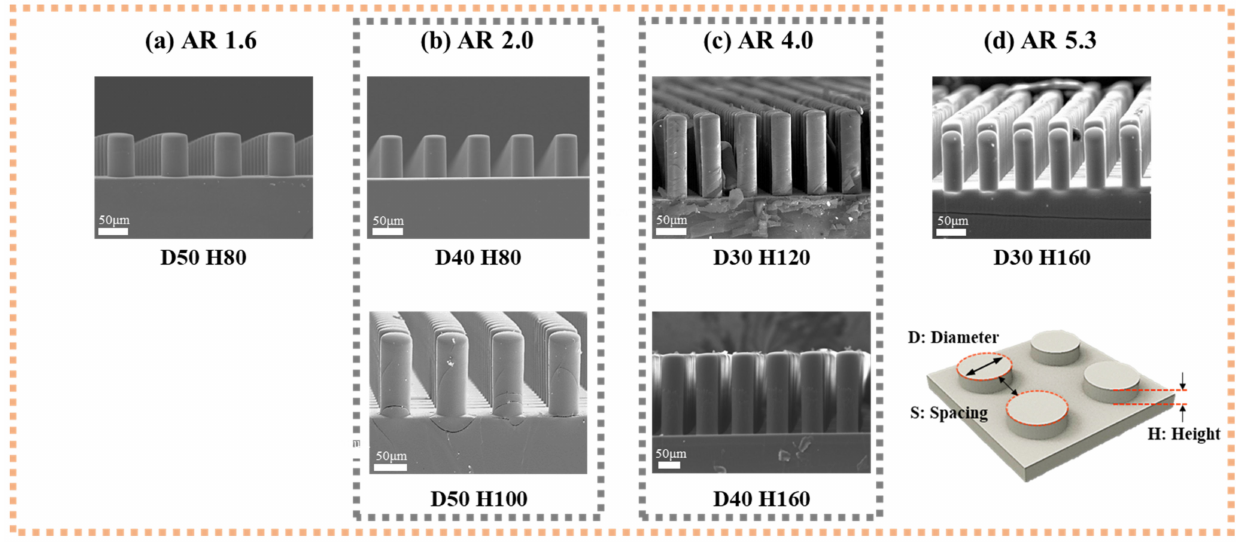
Figure 2. Scanning electron microscopy (SEM) images of prepared PDMS pillar patterned molds: ( a ) aspect ratio (AR) 1.6 [diameter (D) 50, height (H) 80], ( b ) AR 2.0 [D40 H80, D50 H100], ( c ) AR 4.0 [D30 H120, D40 H160], ( d ) AR 5.3 [D30